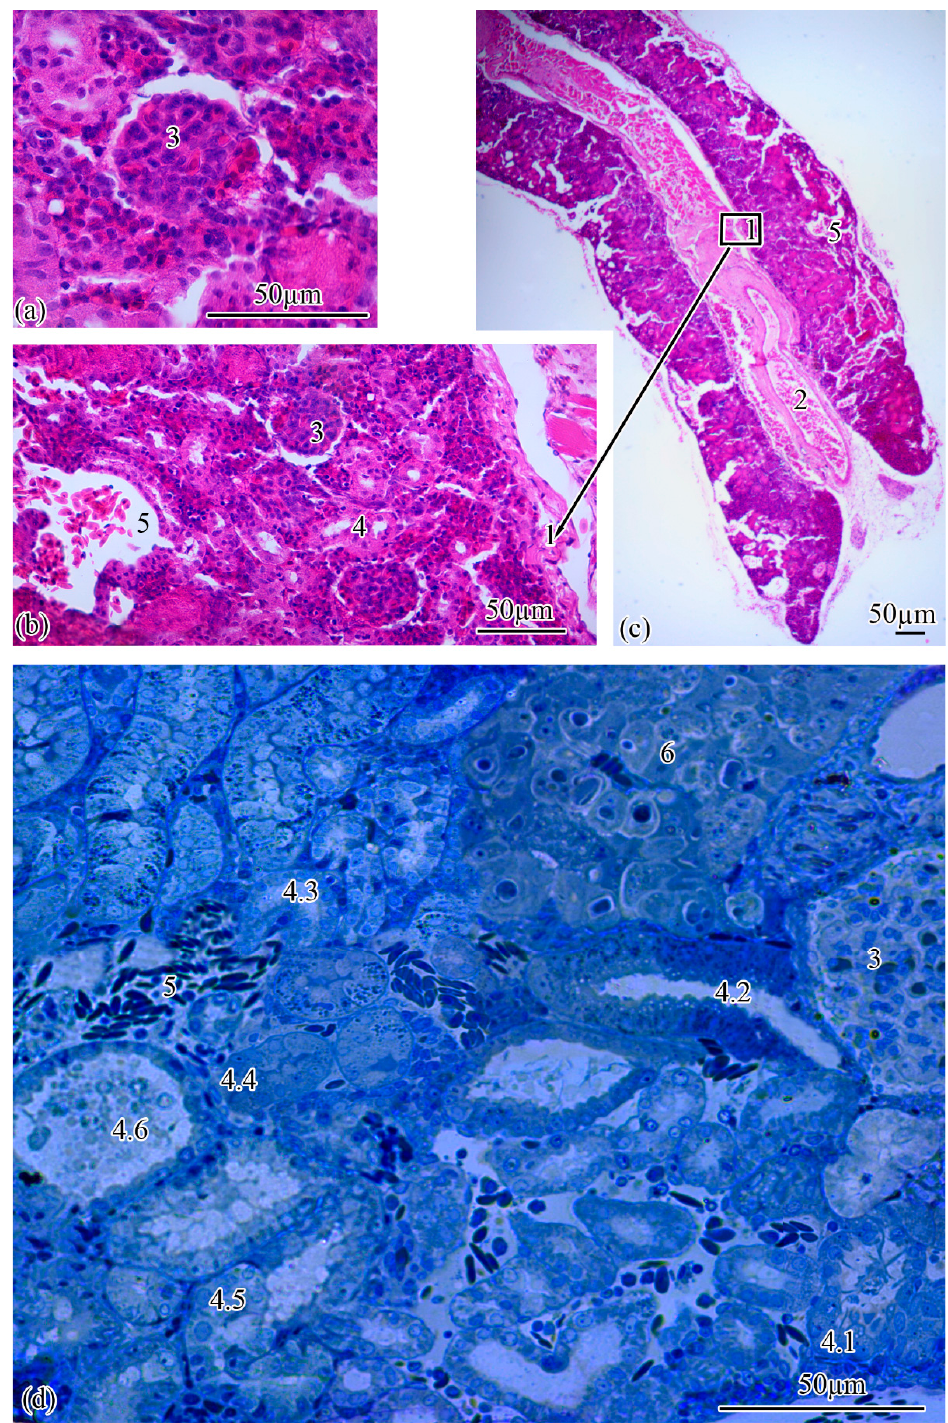
Figure 2. Microanatomy of the trunk kidney ( a – d ). Main structural units: wall of the magistral blood vessel (1), magistral blood vessel (2), renal corpuscle (3), nephron tubules (4), neck segment (4.1), part of the proximal tubule formed by type I epithelial cells (4.2), part of the proximal tubule formed by type II epithelial cells (4.3), part of the distal tubule formed by type I epithelial cells (4.4), part of the distal tubule formed by type II epithelial cells (4.5), collecting tubule (4.6), peripheral blood vessels (5), renal interstitium (6).